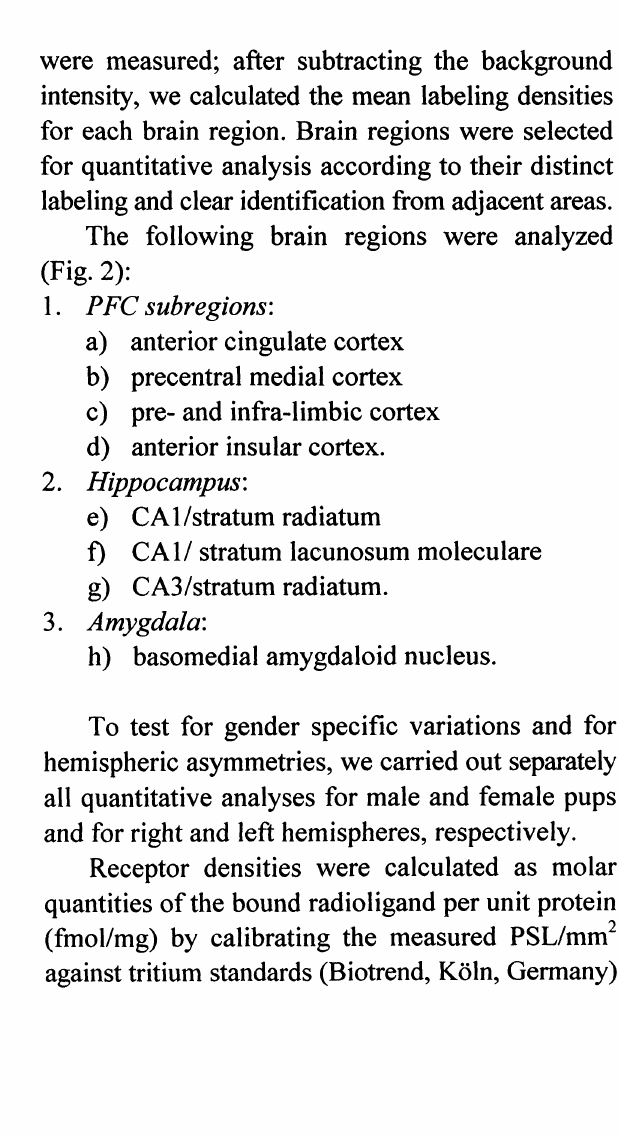
Fig. 1: Experimental procedure for brief parental deprivation and exposure to a novel environment (Open field) with (SPS+T short parental separation + tone) and without (SPS short parental separation) presentation of maternal